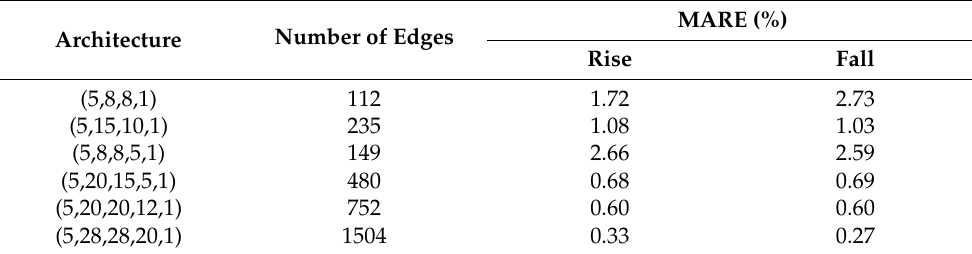
Table 1. Accuracy versus complexity trade-offs in ANN-based interdependent flip-flop timing model. Architecture Number of Edges